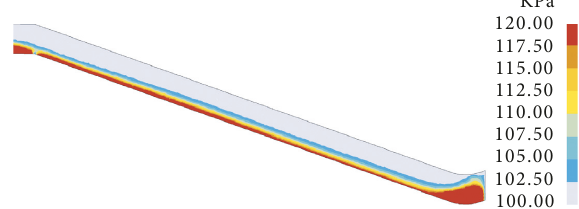
Figure 11: Pressure distribution in the central